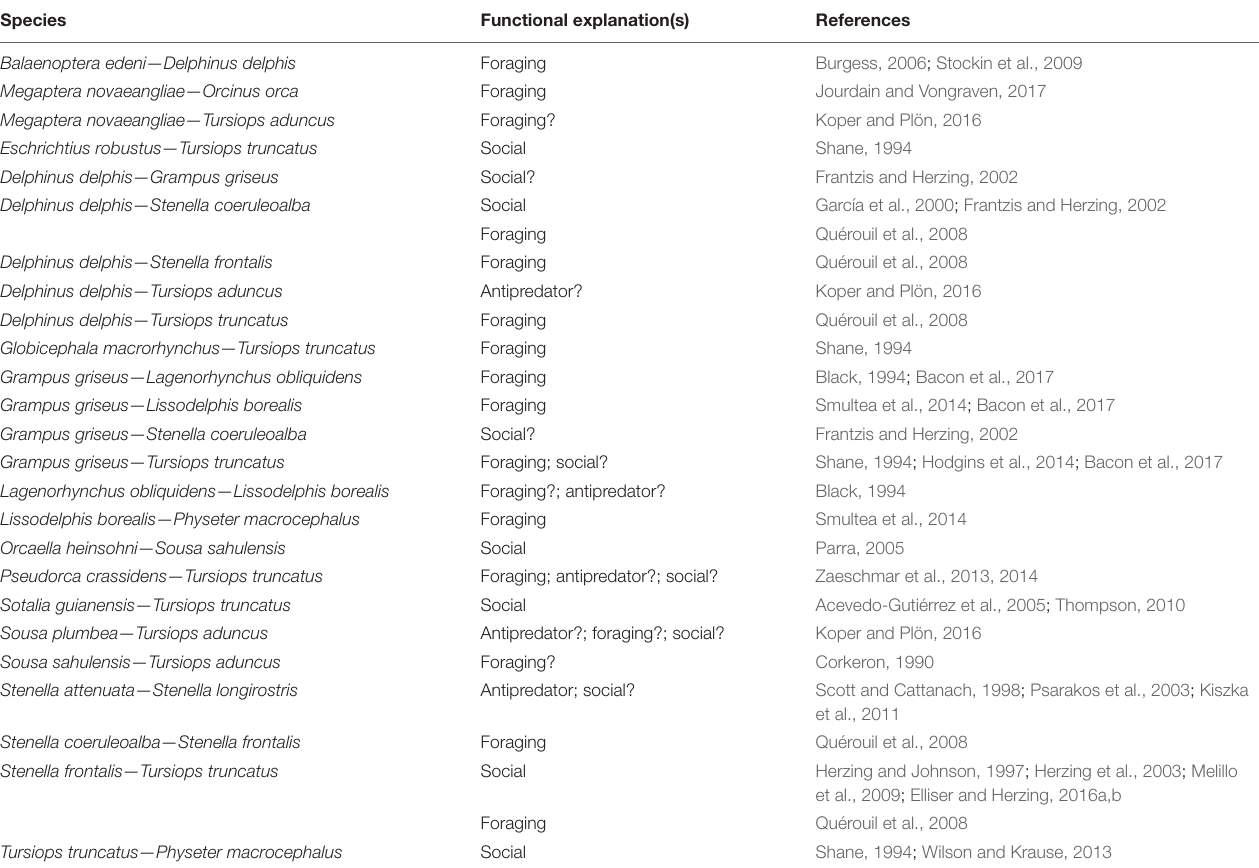
TABLE 4 | Pairs of cetacean species observed in mixed-species groups (MSGs) for which the potential functional explanations have been proposed.